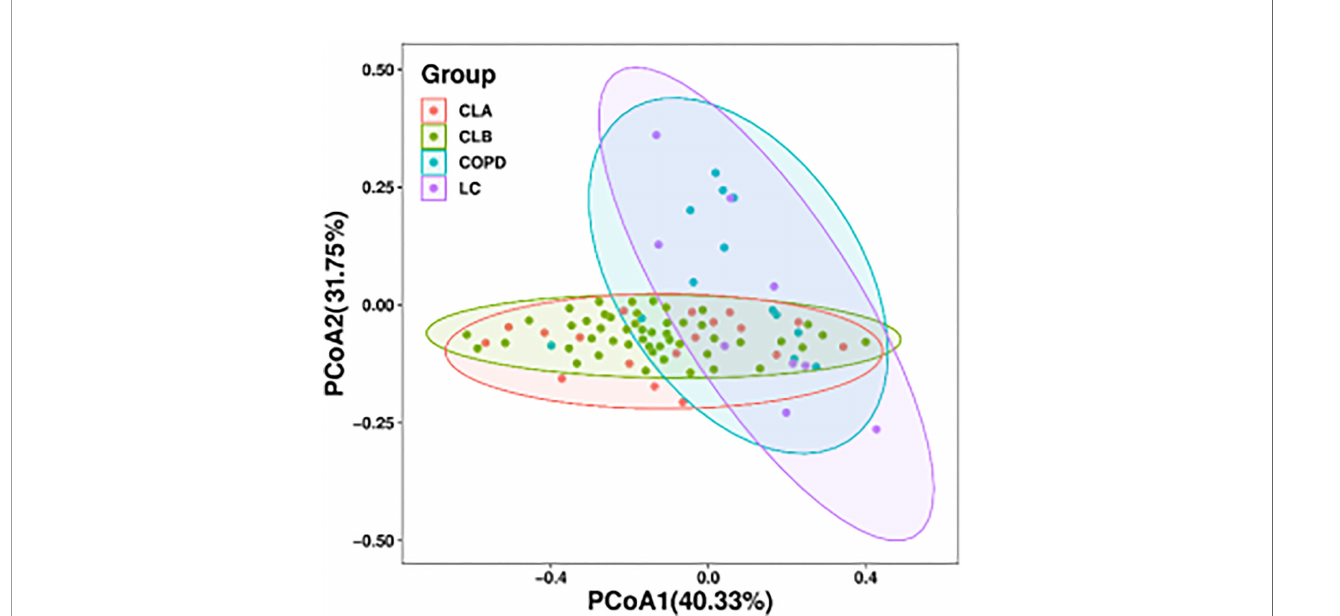
FIGURE 3 | Bacterial diversity clustering by weighted UniFrac principal coordinate analysis (PCoA) of the lung